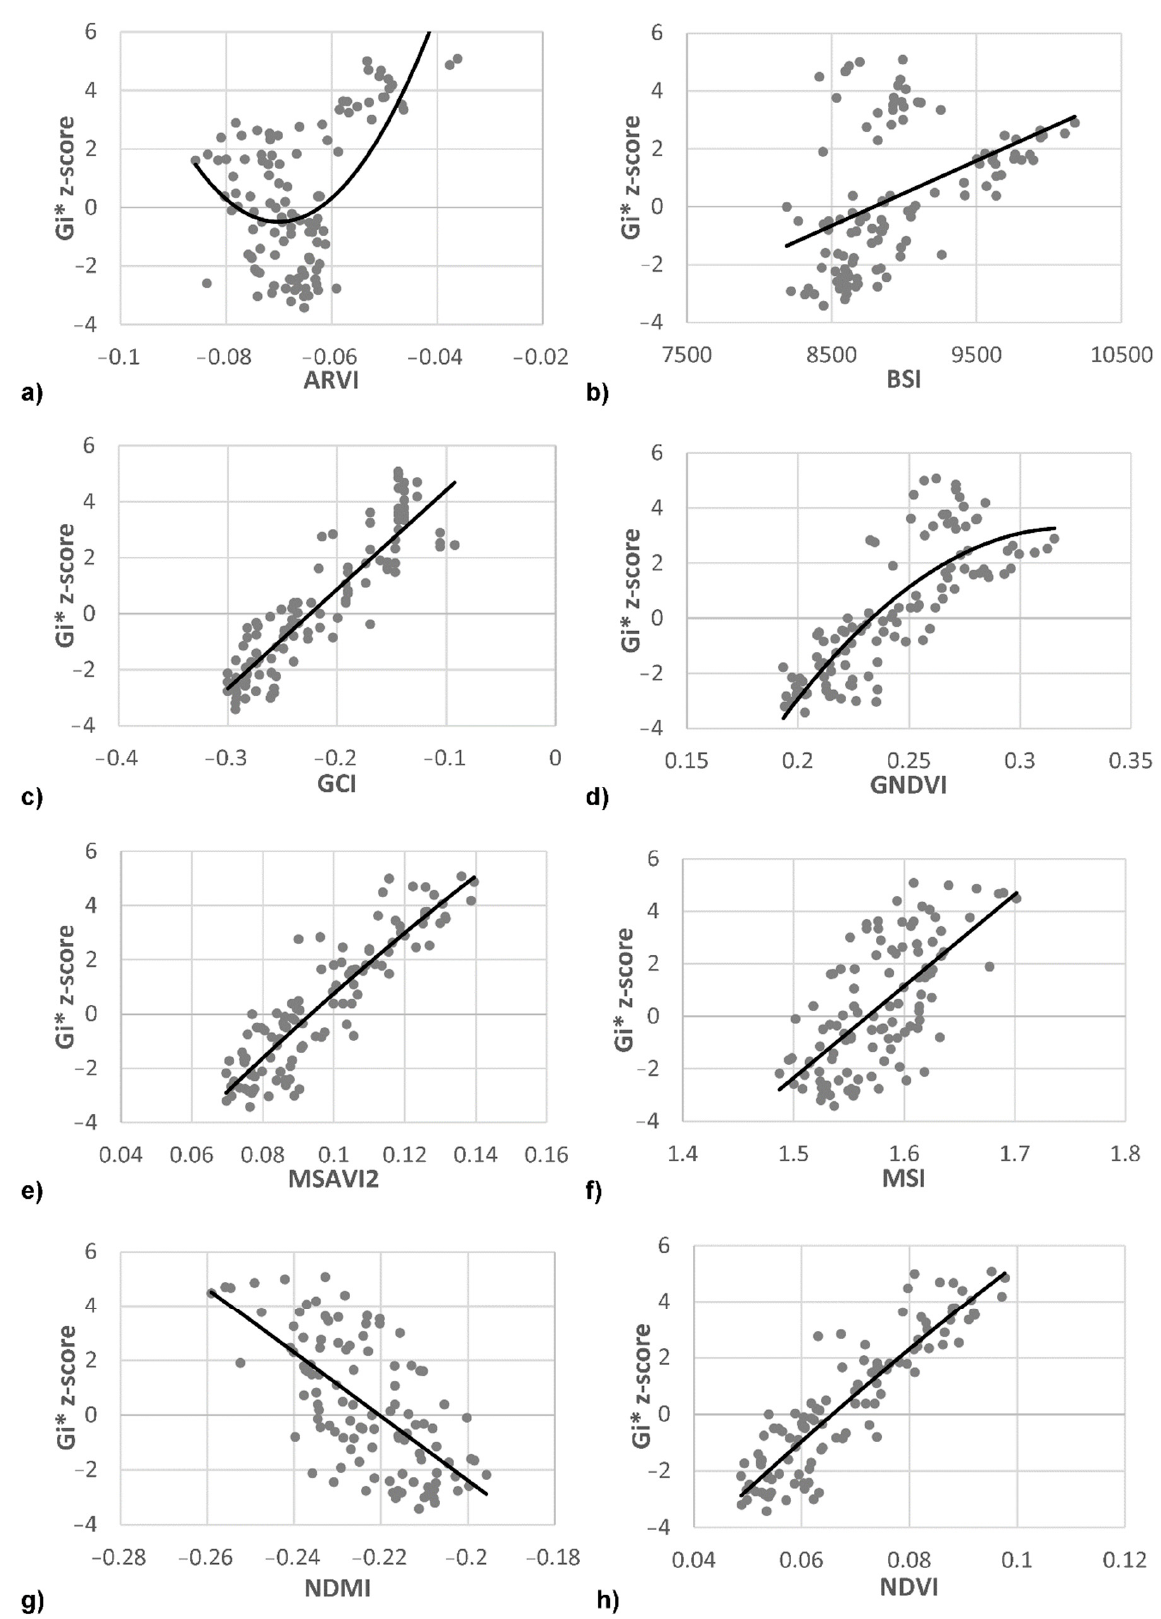
Figure 4. Regressions with untransformed data showing the relationship between the Gi* z-score from the optimized hotspot analysis and the following vegetation and soil moisture index scores: